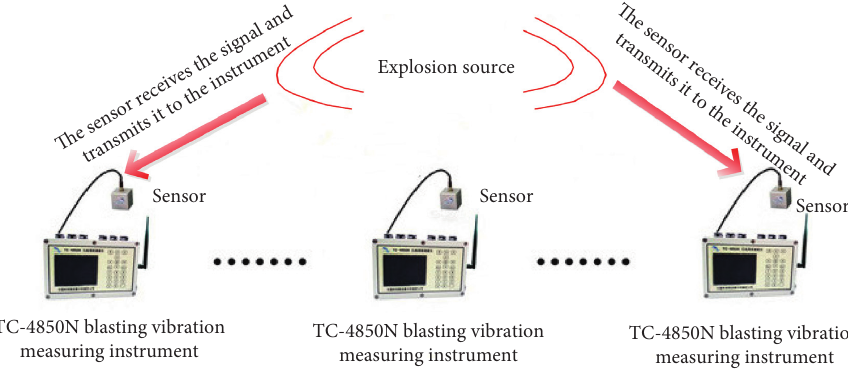
Figure 3: Schematic diagram of TC-4850N wireless blasting